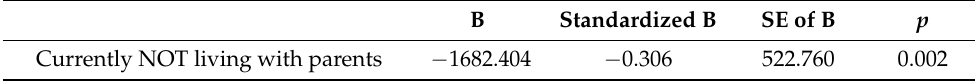
Table 6. Adjusted effects on Steps per Day in the final model.